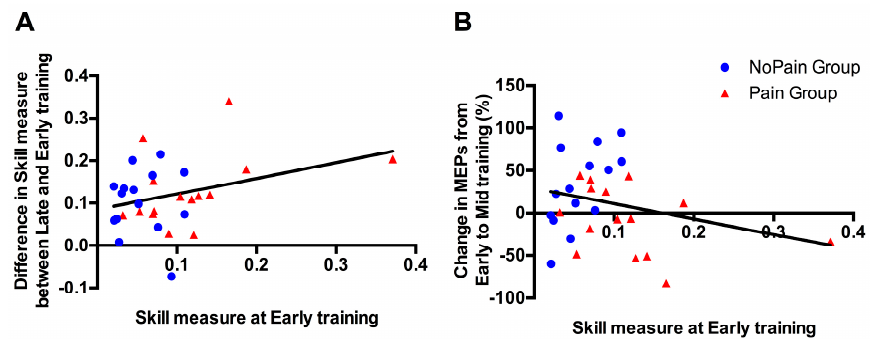
Figure 5. Association between Skill Measure during Early training and ( A ) improvement in Skill Measure from Early to Late training; ( B ) changes in motor evoked potential (MEP) amplitude (%) at Mid training relative to Early training. Blue circles represent subjects from the NoPain group and red triangles subjects from the Pain group. The regression lines have been fitted on data from both groups.